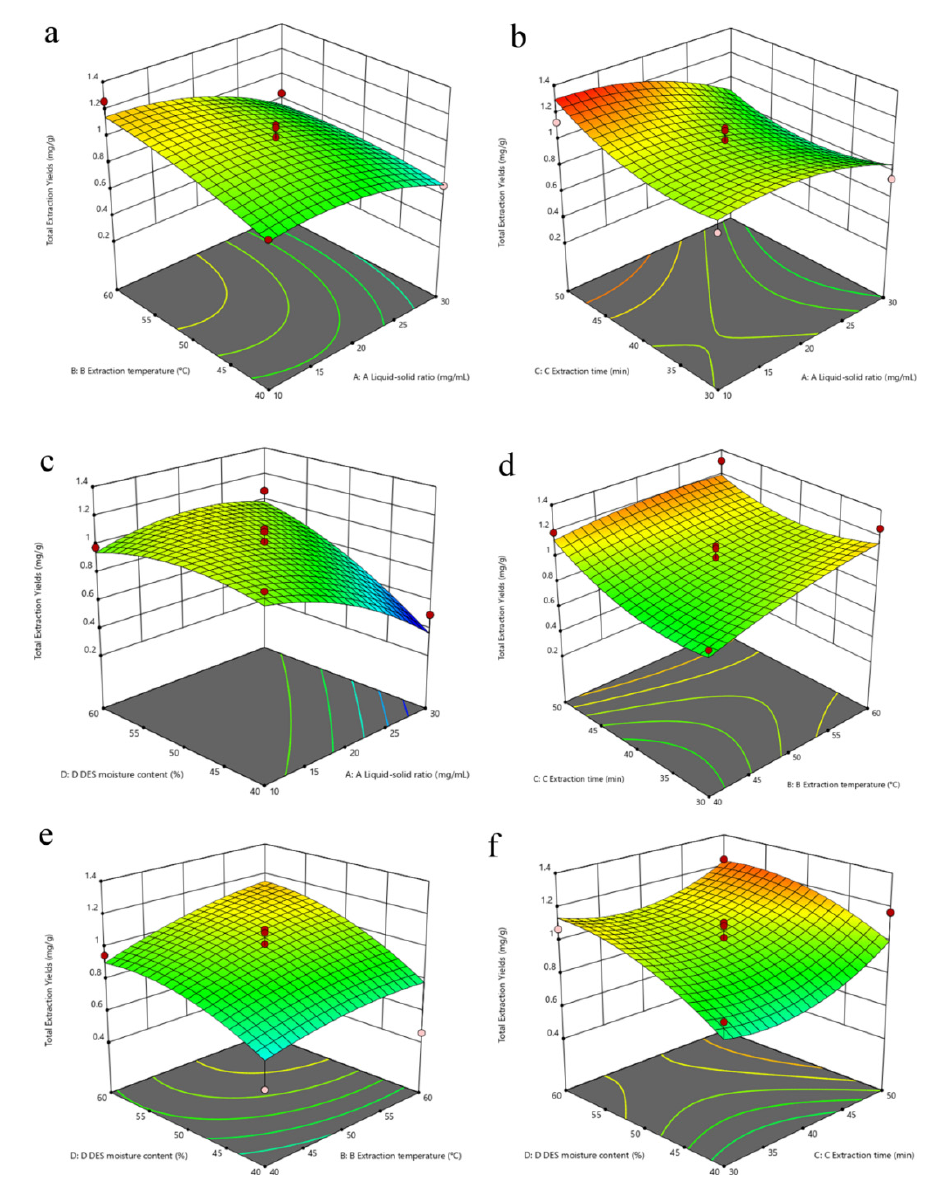
Figure 9. 3D response surface. Notes: ( a ) the reciprocal response of A and B, ( b ) the reciprocal response of A and C, ( c ) the reciprocal response of A and D, ( d ) the reciprocal response of B and C, ( e ) the reciprocal response of B and D, ( f ) the reciprocal response of C and D.